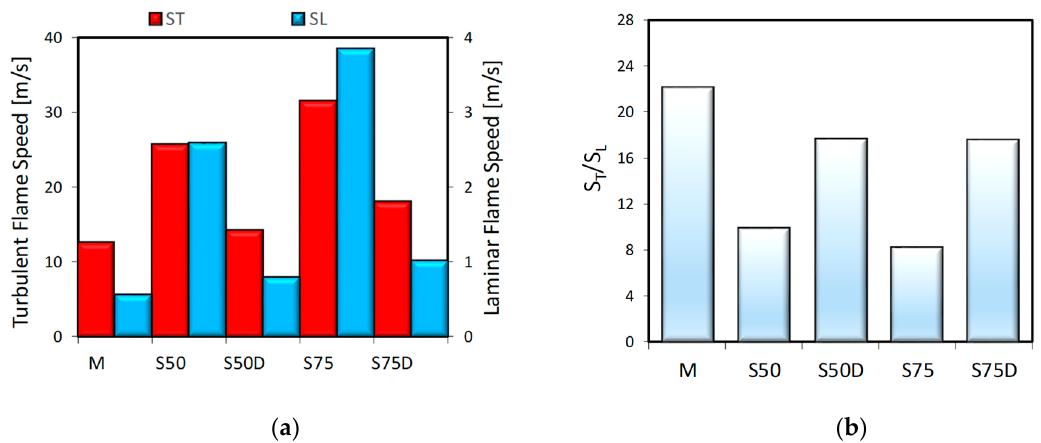
Figure 18. ( a ) Measured turbulent flame speed and calculated laminar flame speed and ( b ) the ratio between turbulent and laminar flame speed for the five different fuels at λ = 1.0 and engine like condition.